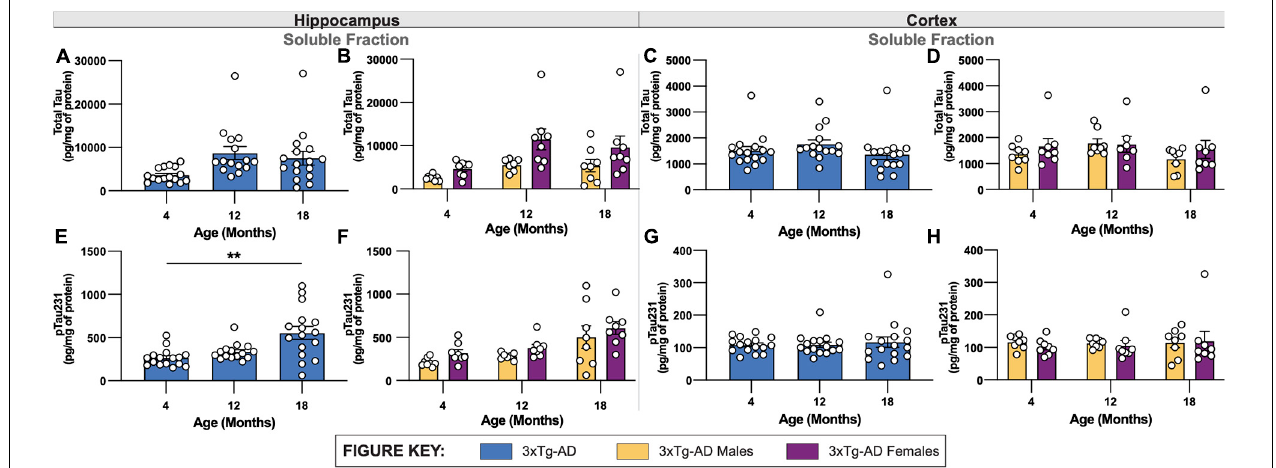
FIGURE 5 | Quantification of total tau and phosphorylated tau in 3xTg-AD mice of different ages and sexes. Levels of total tau and phosphorylated tau were quantified in micro-dissected hippocampi and cortices using Mesoscale Multiplex technology. (A–D) Total tau was measured in the soluble fraction of hippocampus (A,B) and cortex (C,D) , respectively, with no significant differences found between age or sex in either brain regions of 3xTg-AD. (E–H) Levels of phosphorylated tau 231 (pTau231) significantly increased with age specifically in soluble fractions of hippocampus (E,F) but not cortex (G,H) of 3xTg-AD mice. Differences in pTau231 levels were not seen between sexes. n = 5–6 mice per genotype/age/sex. Data are represented as mean ± SEM. ** p ≤ 0.01.